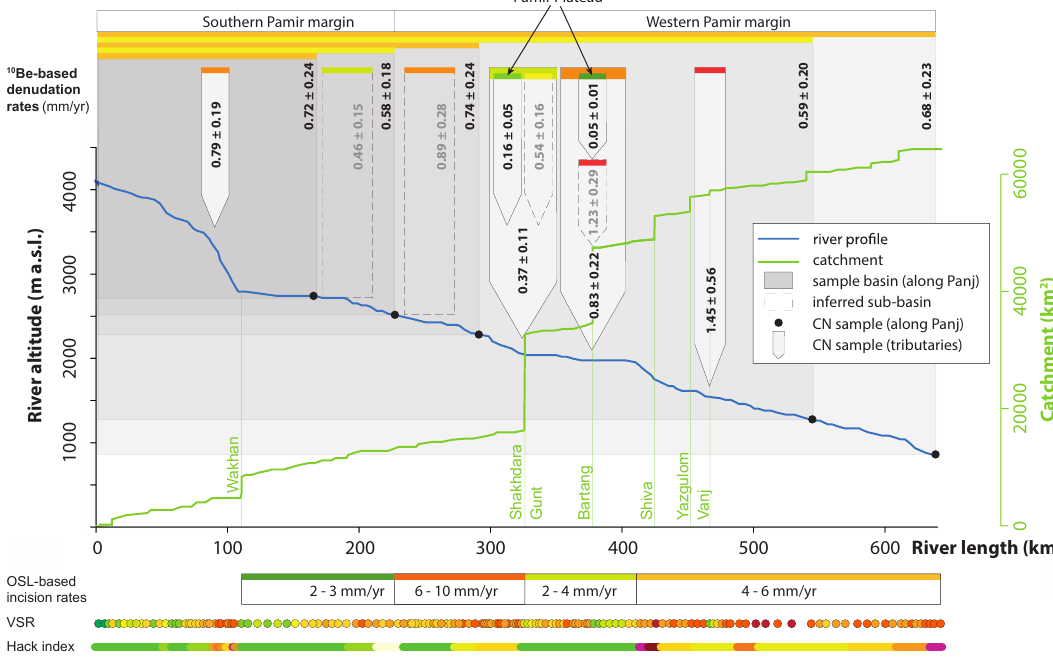
Figure 5. Variation in basin-averaged denudation rates and fluvial incision along the Panj (CN: cosmogenic nuclide; OSL: optically stim- ulated luminescence). The along-Panj samples (filled circles) represent 10 Be-based denudation rates that integrate over related upstream areas (grey shaded areas). Major tributaries and their sub-basins show local differences in denudation between marginal and plateau-related basin sections. The colour code illustrates the magnitude of denudation rates (green: low; red: high) and indicates the respective basin area. OSL-based incision rates, valley shape ratios (VSR) and Hack indices (Fuchs et al., 2013, 2014) along the Panj represent the pattern of fluvial incision that determines the lowering of local base levels at the Pamir